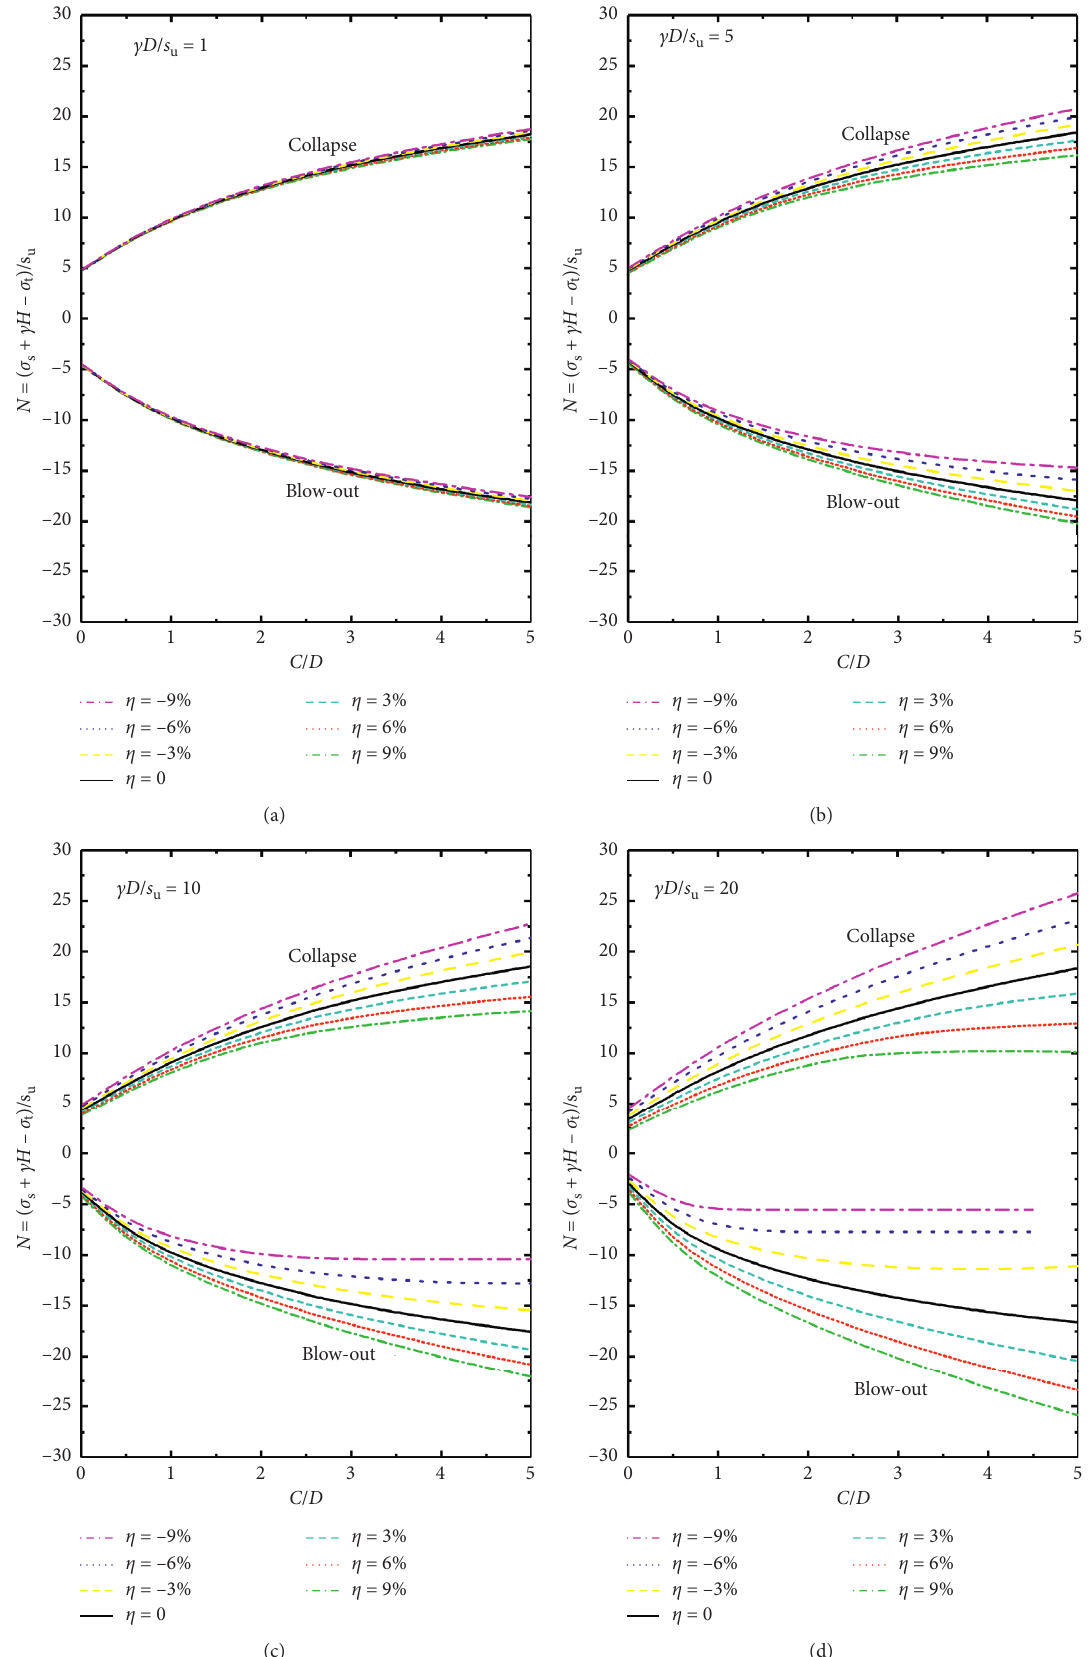
Figure 3: Stability numbers for the face stability of the circular tunnel with different longitudinal